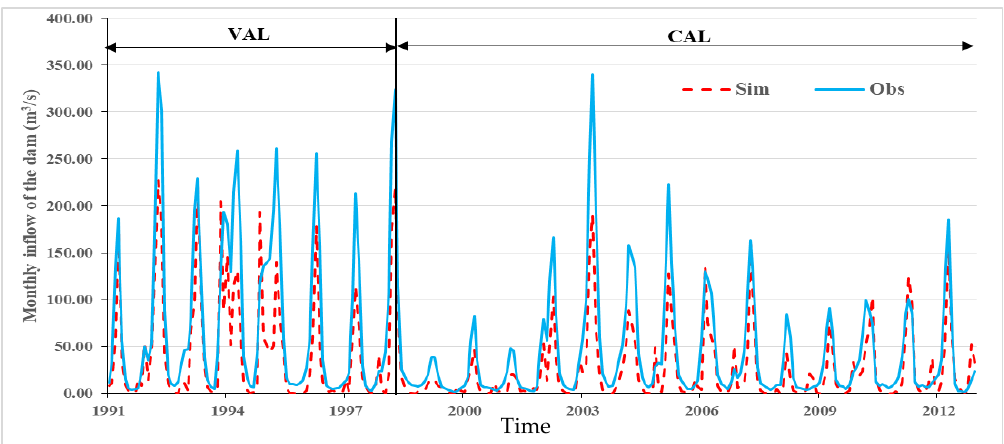
Figure 4. Simulated and observed Boukan Dam inflow for the calibration and validation periods.